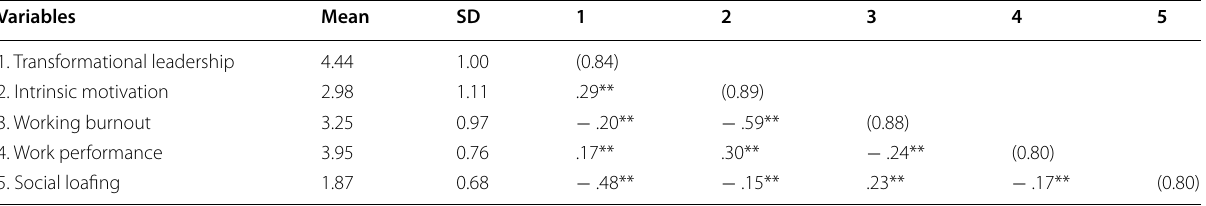
Table 2 Mean, standard deviations and correlations